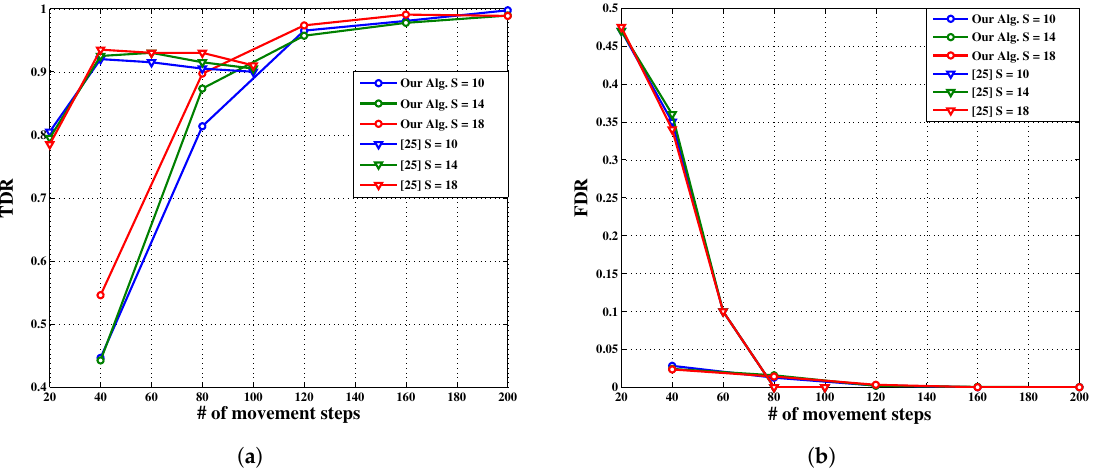
Figure 13. Performance comparison of [25] and our new proposed method in terms of TDR ( a ) and FDR ( b ) versus number of movement steps for varying number of Sybil